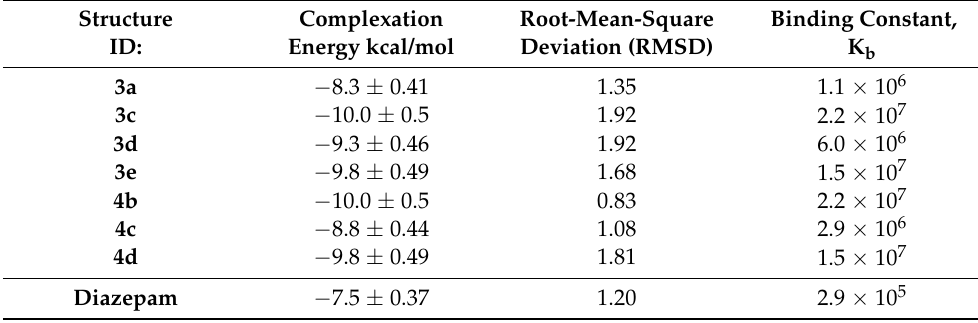
Table 7. Biophysical calculation of complexations of compounds ( 3a , 3c – e and 4b – d ) and diazepam